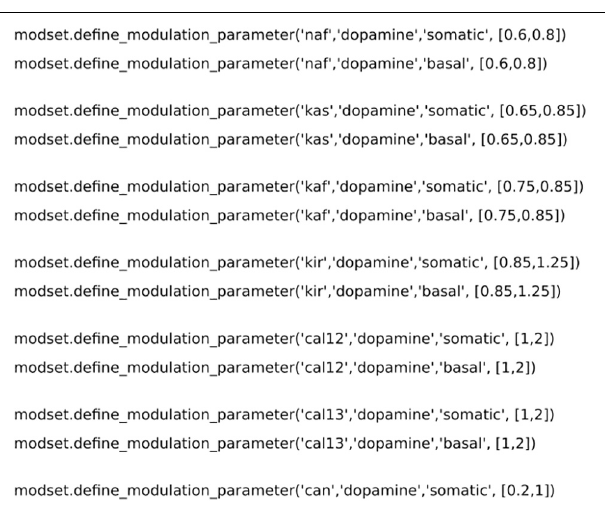
FIGURE 3 | Code for setting up the parameter variation for neuromodulation. modset.define_modulation_parameter accepts the ion channel name, neuromodulator, part of the morphology and the intervals of modulation. Here we have used data from previous publications (Lindroos et al., 2018; Lindroos and Hellgren Kotaleski, 2021).